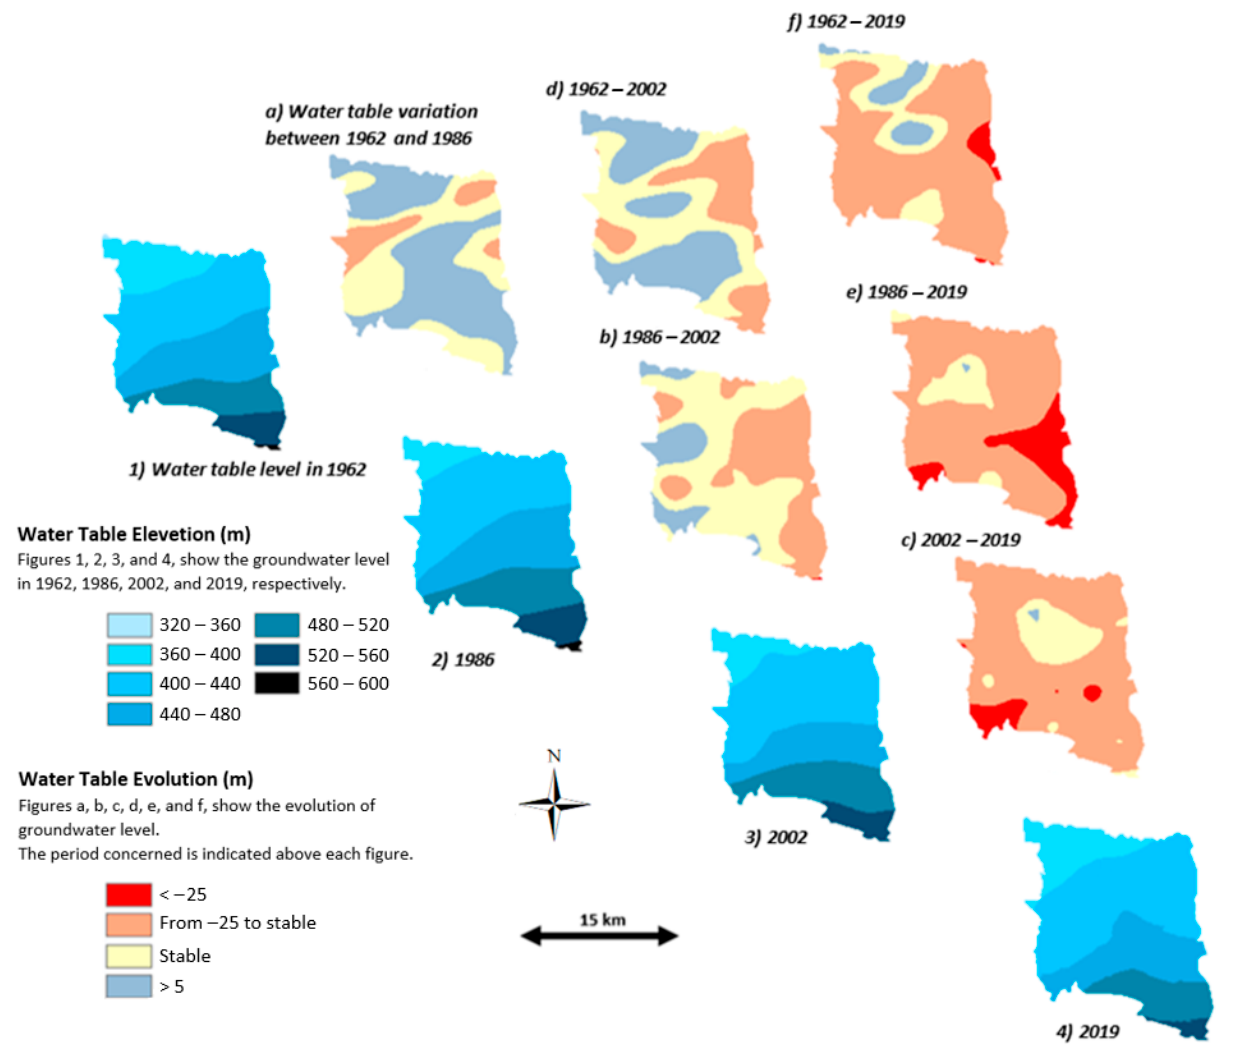
Figure 8. Fluctuation of groundwater level between 1962 and 2019.